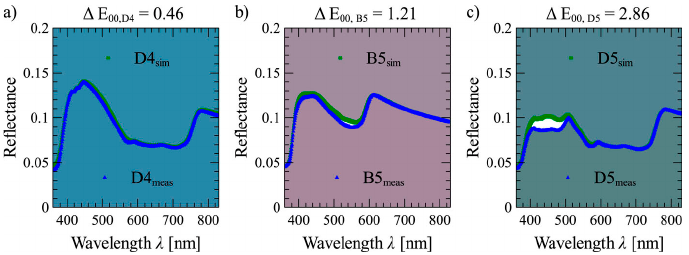
Figure 9. Examples of measured and simulated reflectance spectra for three target colours (D4 in subfigure ( a ), B5 in subfigure ( b ) and D5 in subfigure ( c )) in the visible spectrum, and calculated colour difference. Reproduced with permission from [20], copyright 2021, AIP